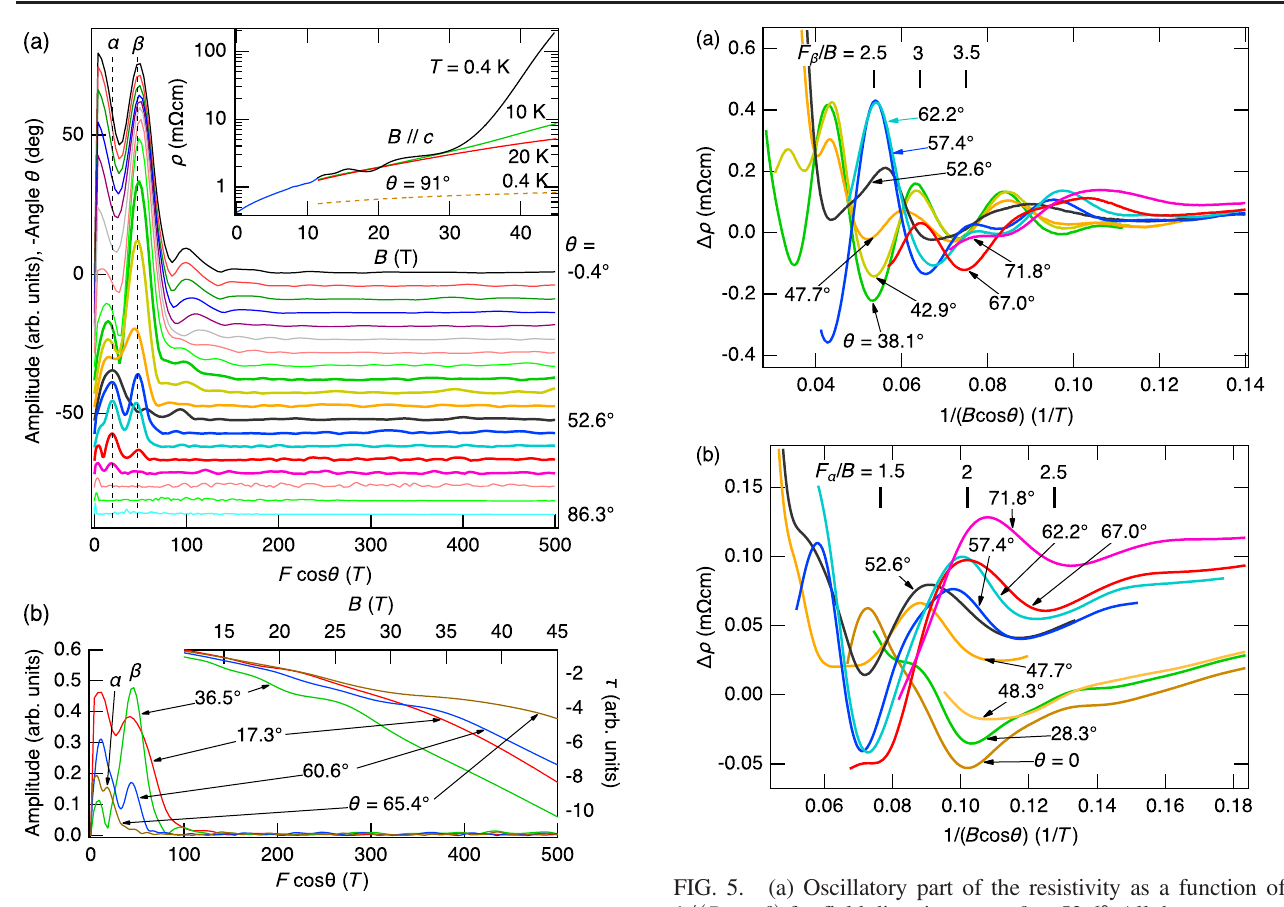
FIG. 4. (a, inset) In-plane resistivity in CaFeAsF as a function of B up to 45 T for B ∥ c and nearly B ∥ ab ( θ ¼ 91 °). (a, main) Fourier transforms of d ln ρ =dB vs 1 =B over the field range 11.4 – 44.7 T for various field directions θ . Note that the horizontal axis is F cos θ . The spectra are vertically shifted as in Fig. 3(b). (b) Magnetic torque τ in CaFeAsF (upper right) and correspond- ing Fourier transforms of d τ = dB vs 1 =B plotted against F cos θ .